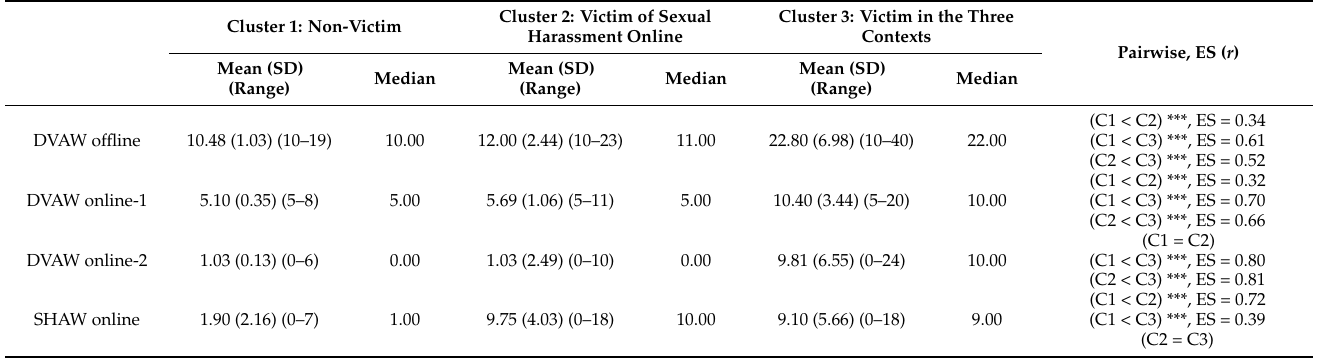
Table 2. Descriptive statistics of cluster variables and significant of the differences among